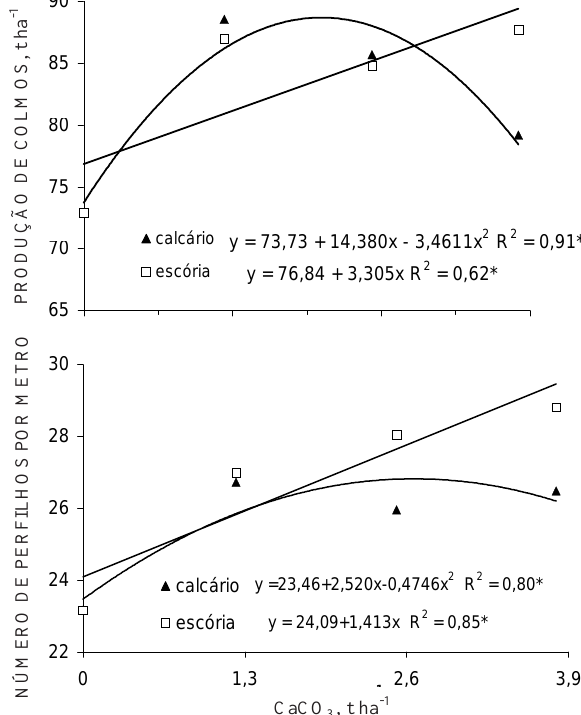
Figura 4. Efeito da aplicação do calcário e da escória de siderurgia na produção de colmos e no perfilhamento da cana-de-açúcar. (Dados médios da cana-planta e cana-soca e quatro